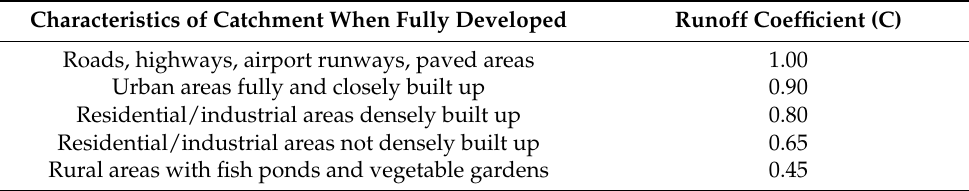
Table 1. C-values indicated in PUB’s Code of Practice on Surface Water Drainage [8]. Characteristics of Catchment When Fully